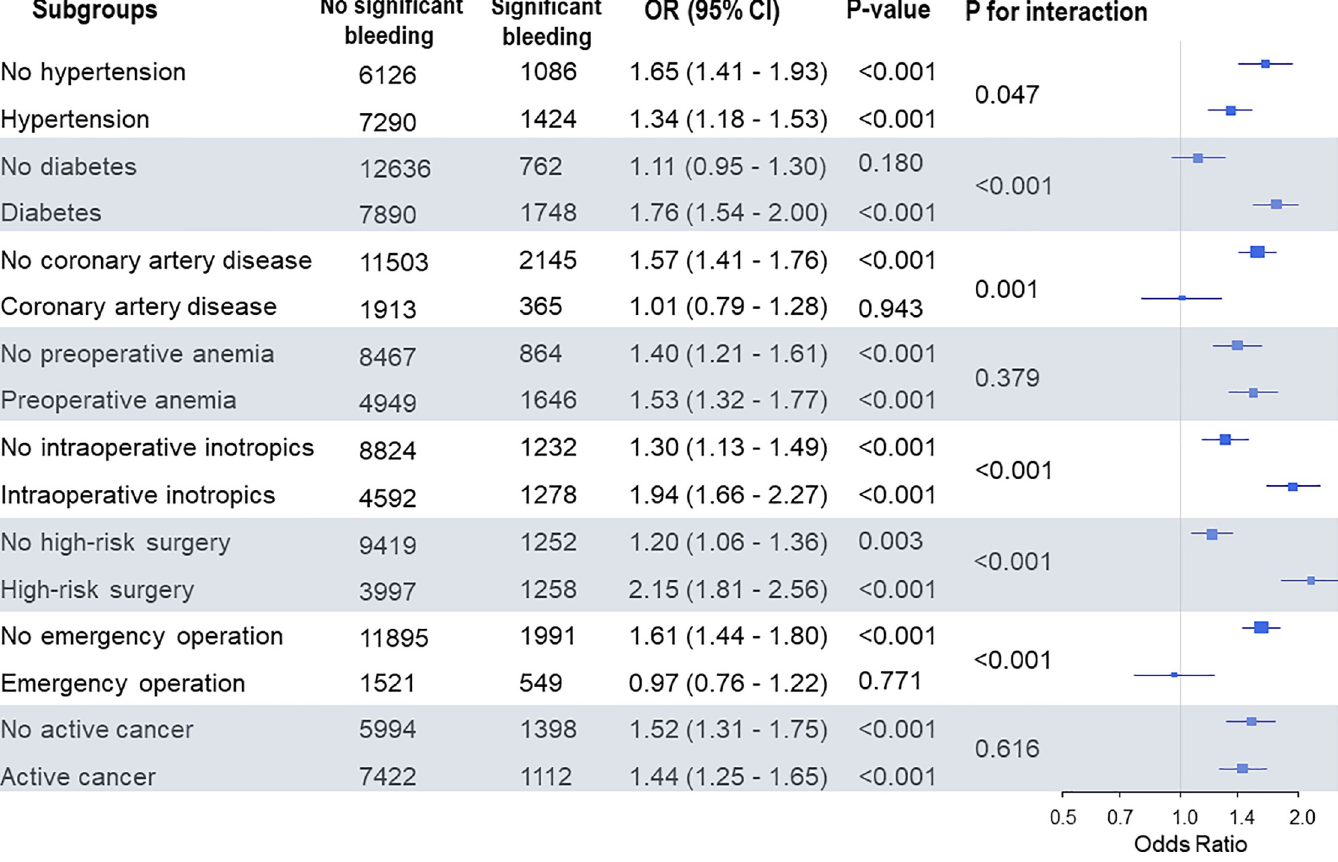
Fig 2. Forest plot for subgroup